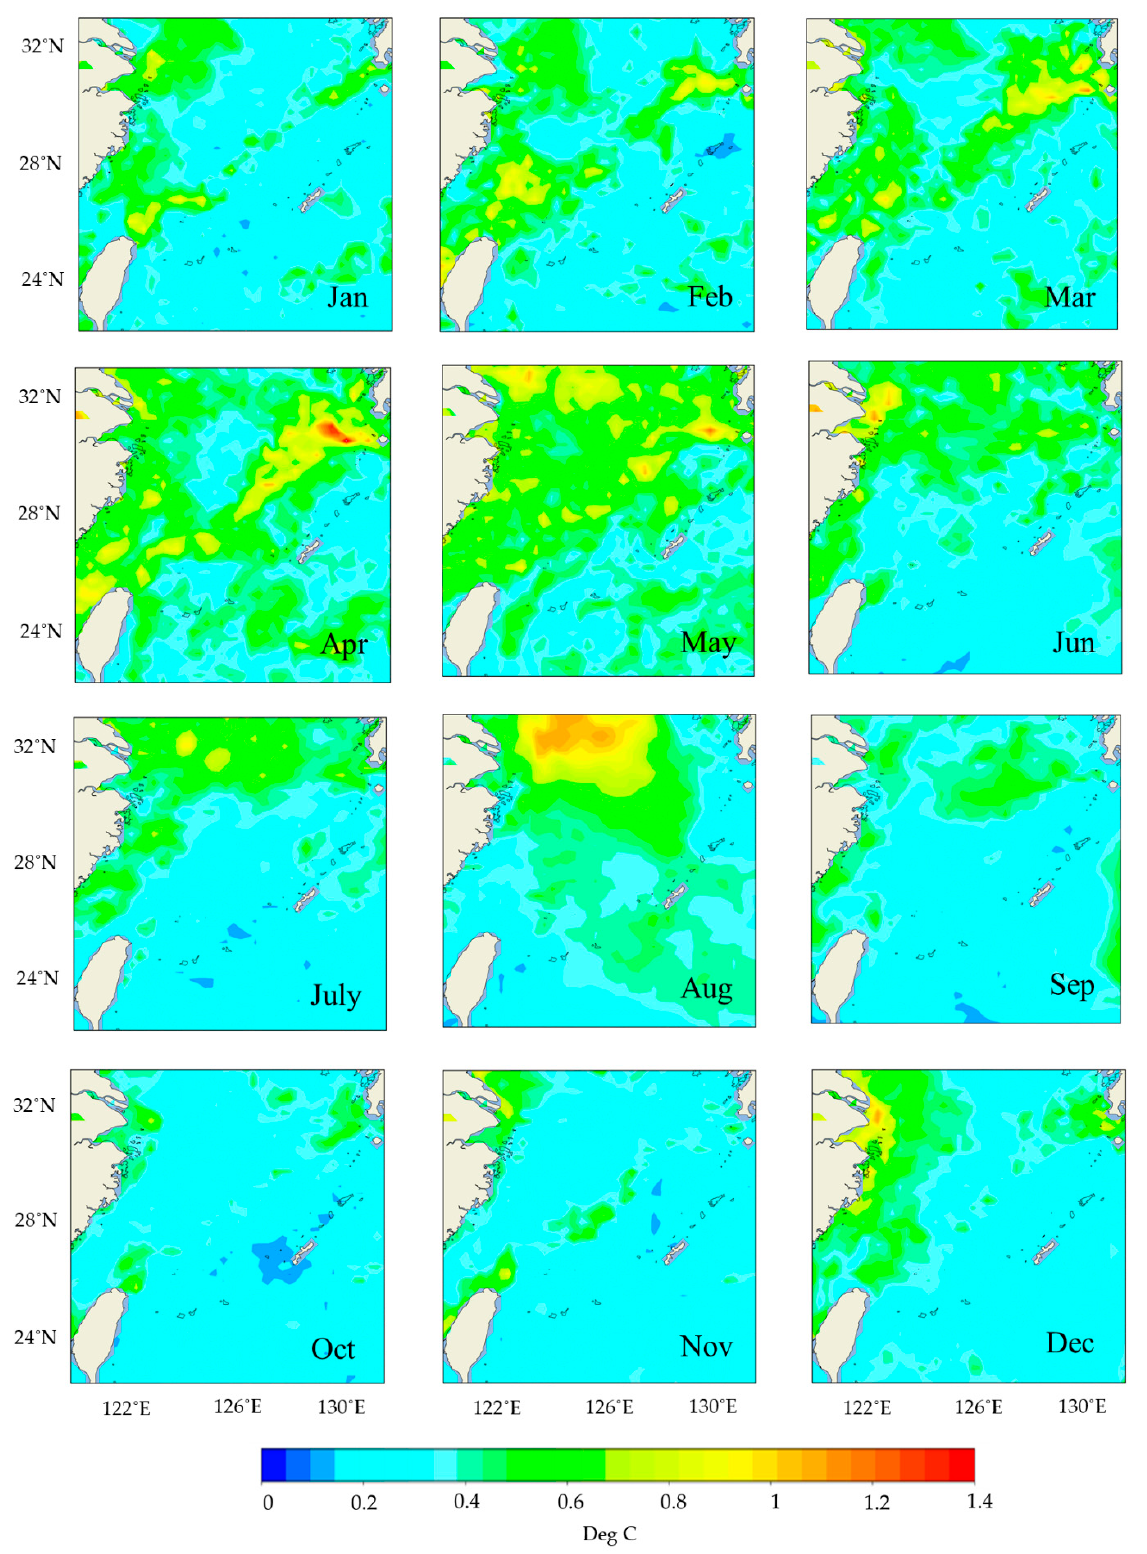
Figure 9. Spatial distribution of monthly mean RMSE between LSTM predicted sea surface temperature and OSTIA data in 2020. The unit of colorbar is degrees Celsius.